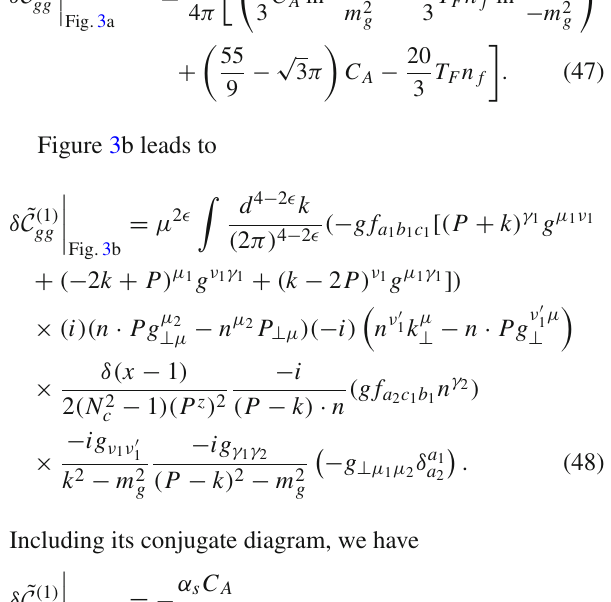
before the UV subtraction. As we have shown in the last sec- tion, there is no ˜ μ dependence but P z in the real corrections of quasi PDFs. Therefore, we fix the scale ˜ μ to P z in self- energy correction of the external gluon line and subtract the UV pole. Such a procedure yields